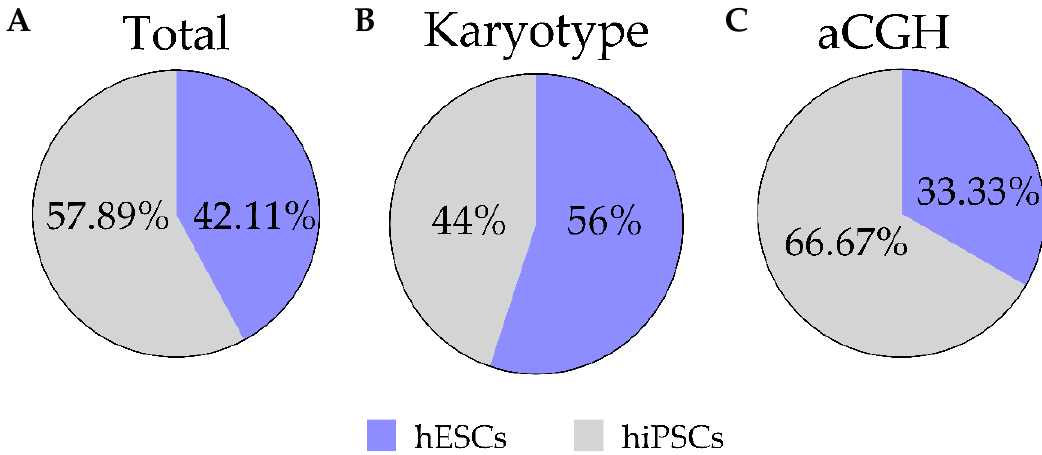
Figure 2. Descriptive statistics of the analyzed dataset. Pie charts showing the relative amount (%) of hESC and hiPSC lines used in this study ( A ), as well as the proportion of G-banding ( B ) and CGH array (aCGH) ( C ) which were performed in each of the hPSC types.